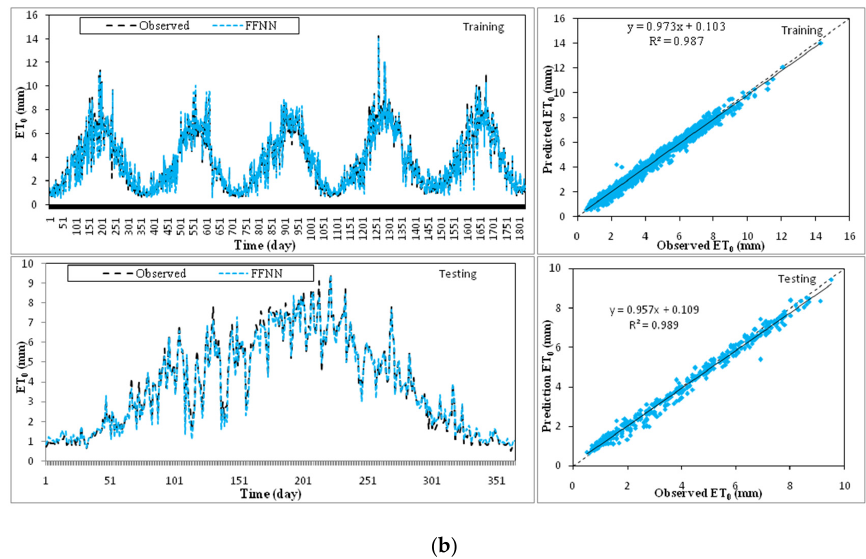
Figure 5. Performance of the best performing ( a ) FFNN M2 and ( b ) FFNN M11 models for both training and testing stages.